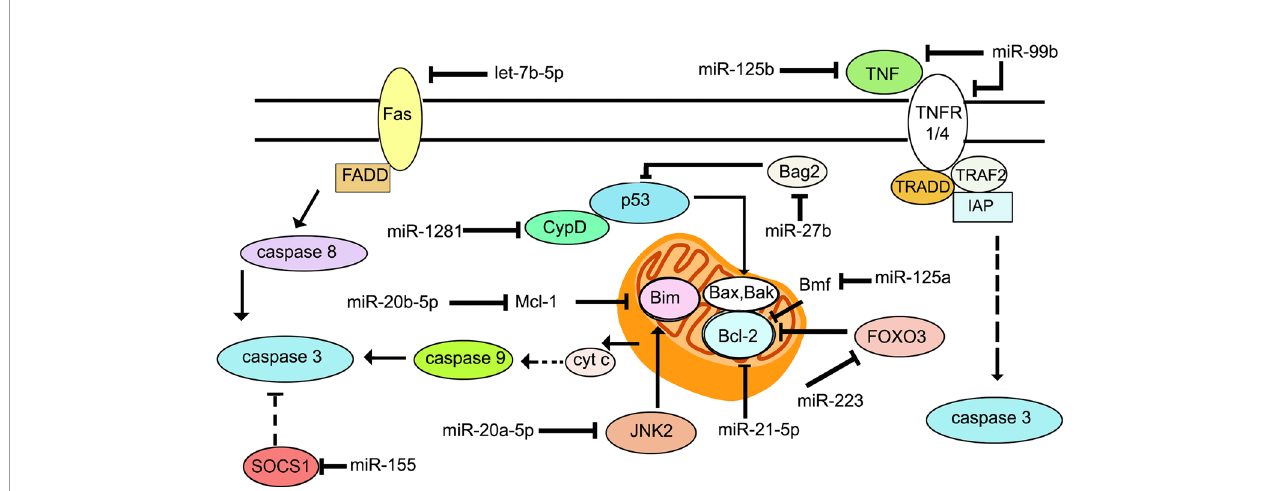
FIGURE 2 | Schematic representation of the key molecules of apoptosis targeted by miRNAs during M. tuberculosis